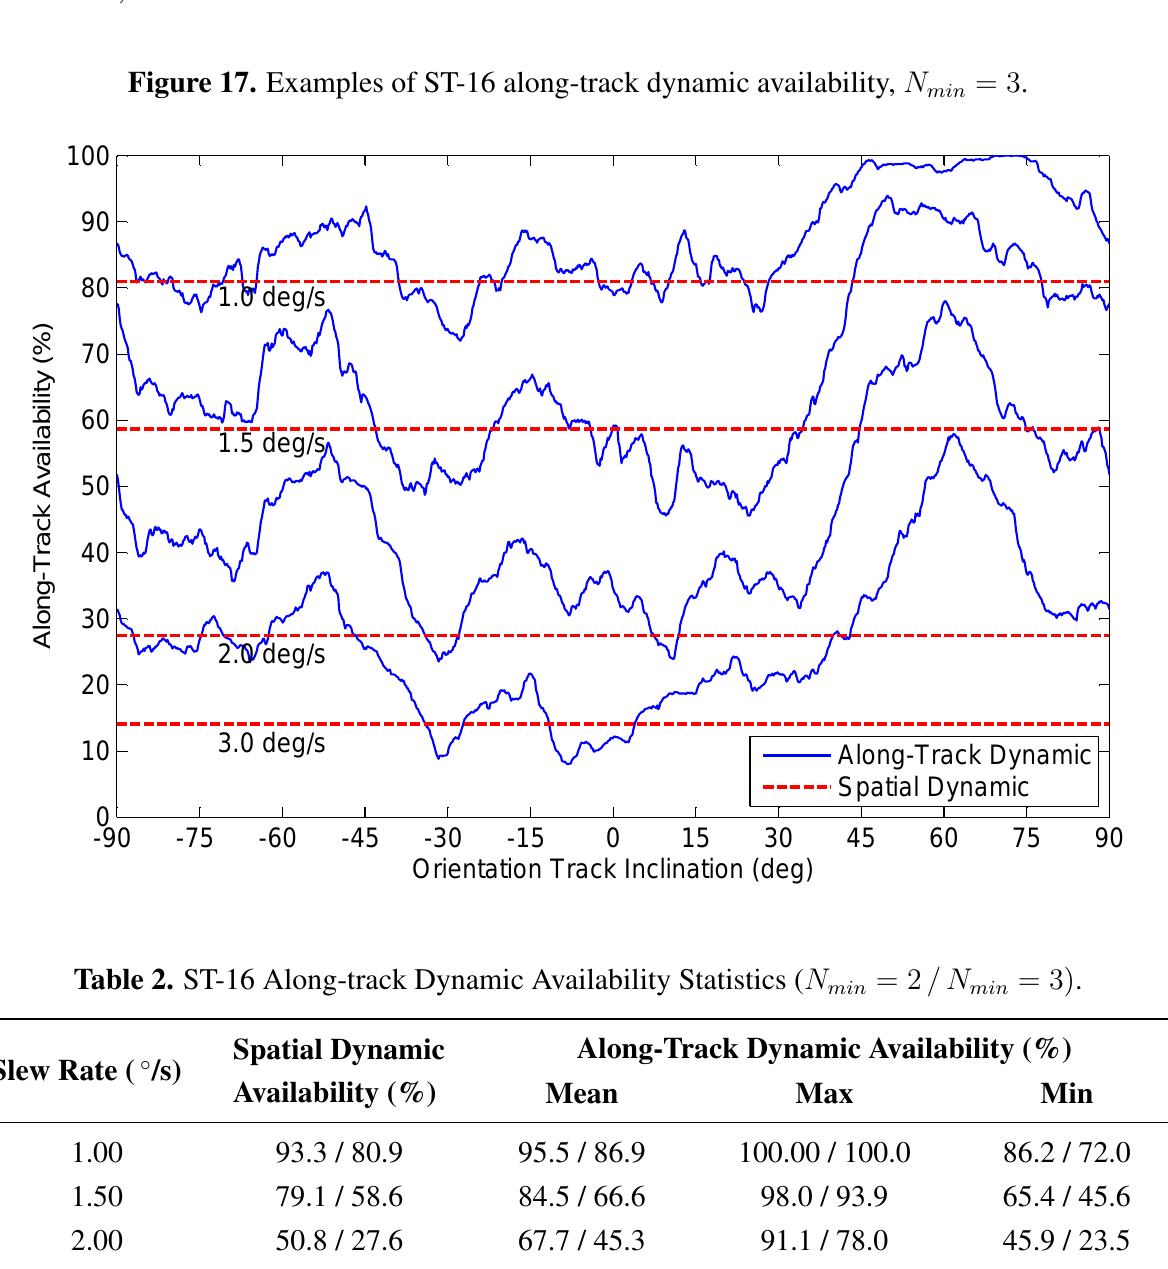
Figure 17. Examples of ST-16 along-track dynamic availability, N